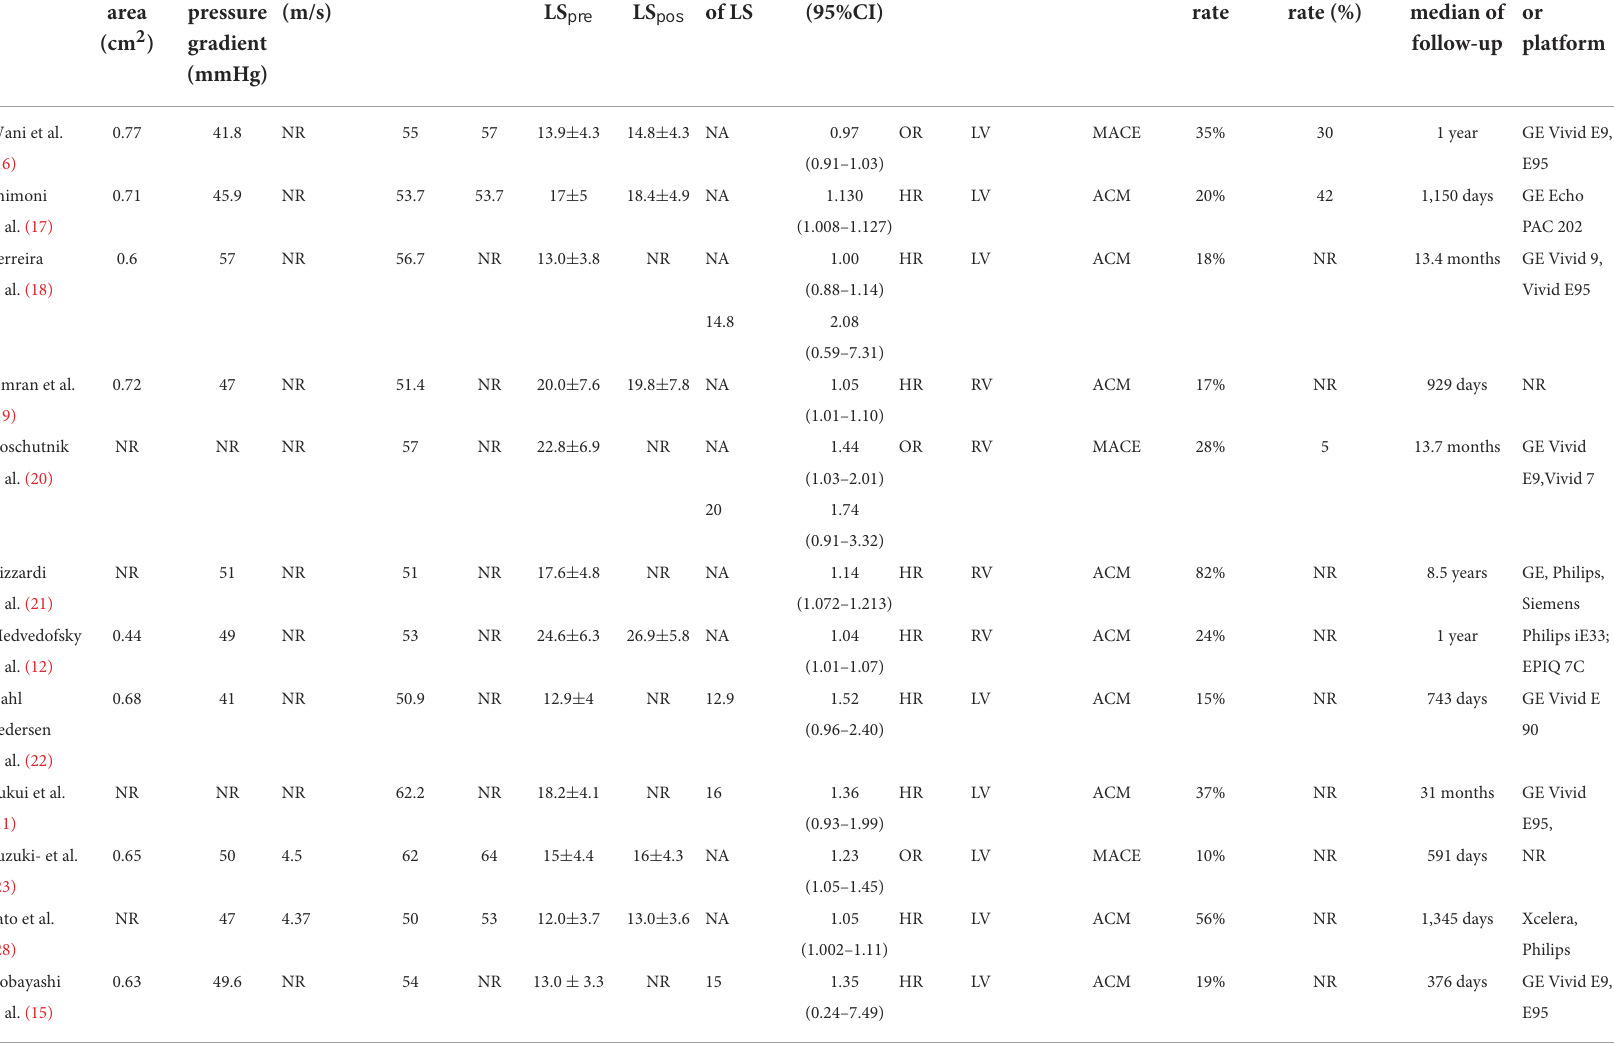
TABLE 2 Echocardiographic parameters and prognostic information of included